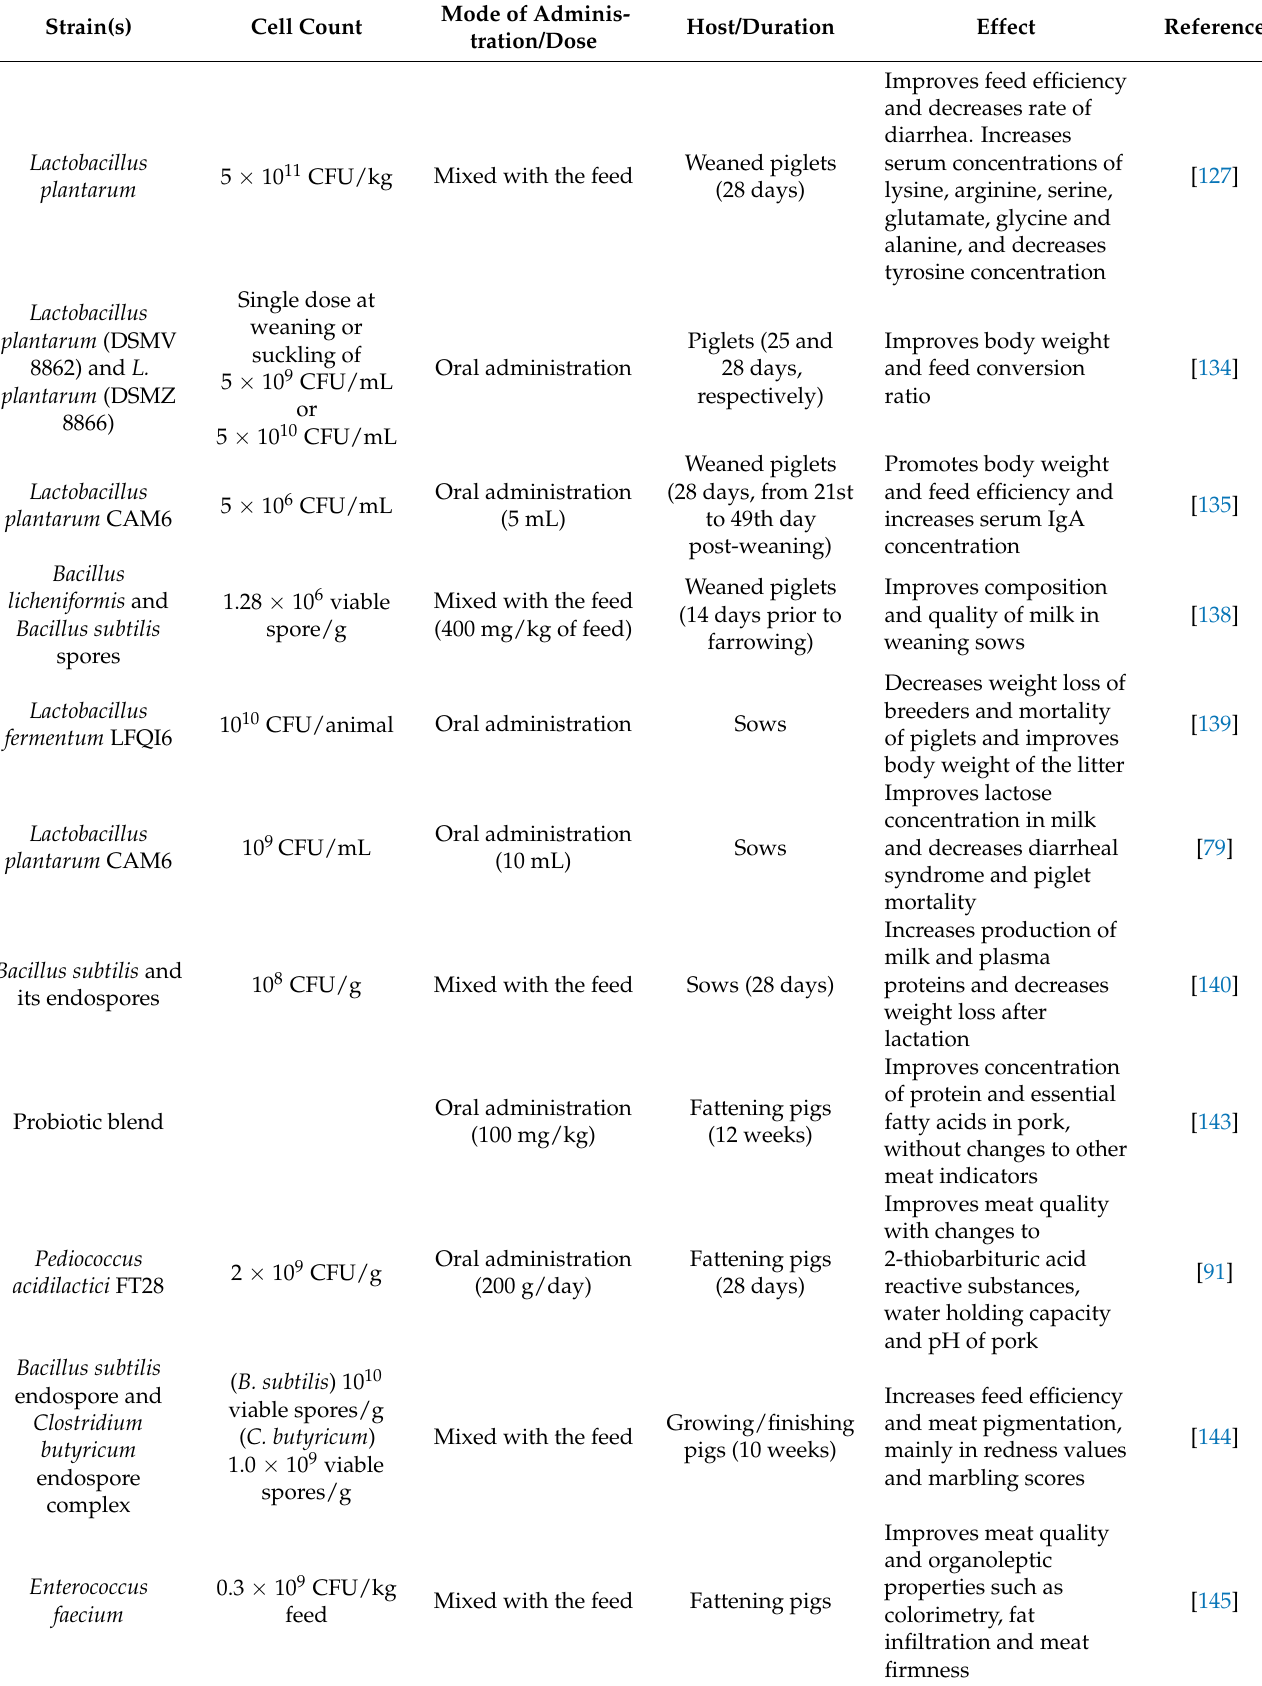
Table 3. Effects of probiotics on swine